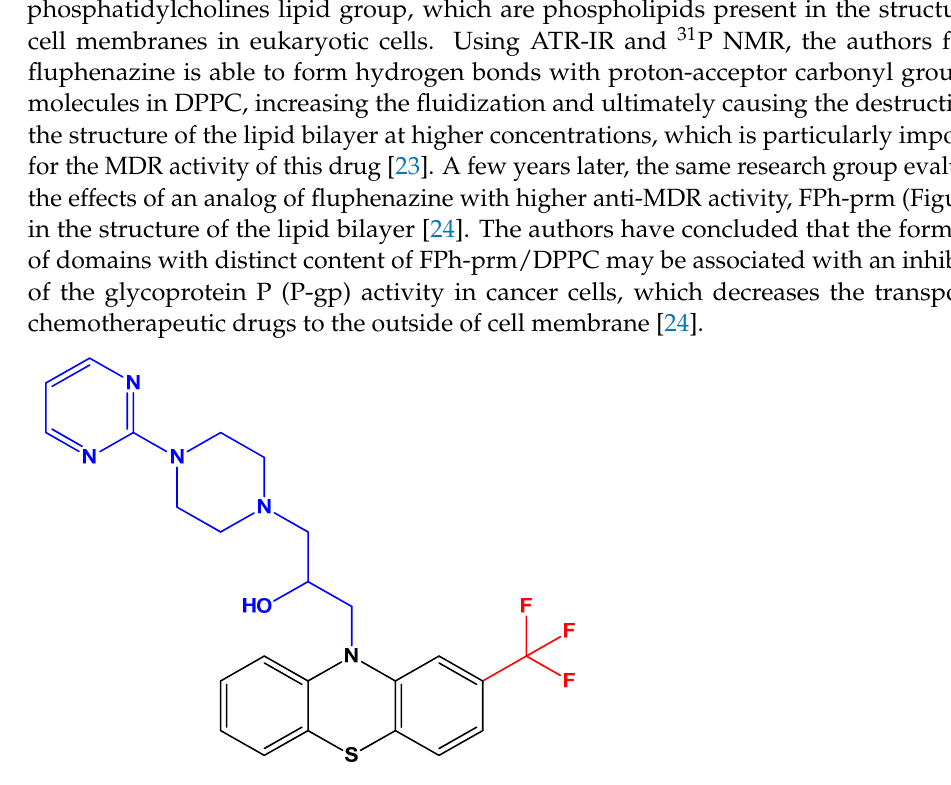
Figure 3. Chemical structure of FPh-prm, an analog of fluphenazine with higher anti-MDR activity. The structure was obtained using ChemDraw software (version 12.0, PerkinElmer, Inc., Waltham, MA, USA). Adapted from [24].